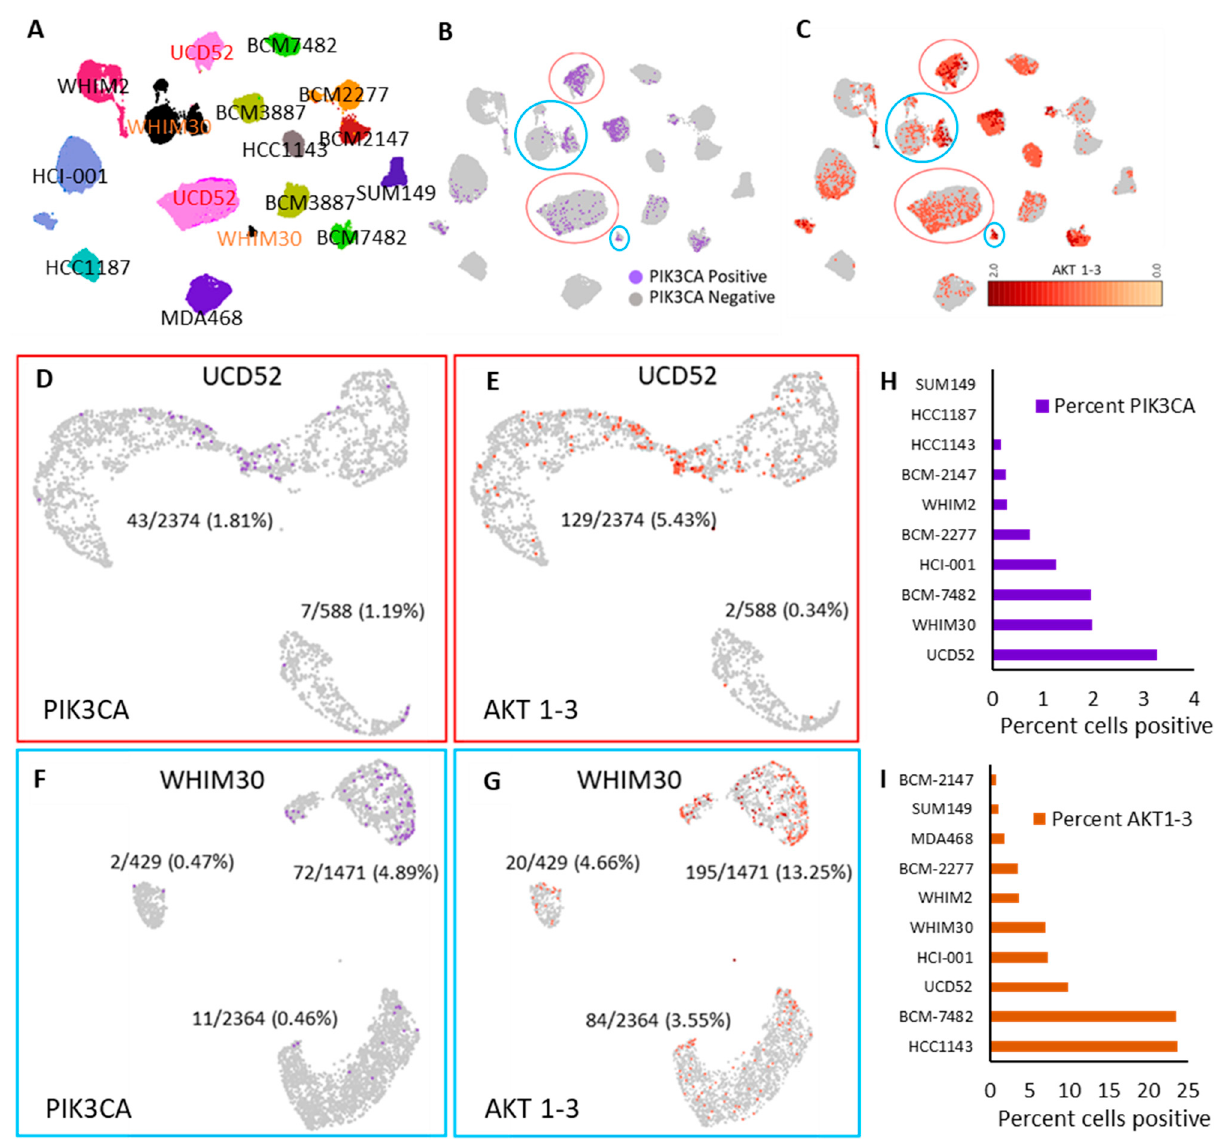
Figure 2. Subpopulations less reliant on the PIK3CA pathway were identified among 2 basal-like PDX models. ( A ) UMAP using the Gatza et al. The 2017 PIK3CA signature of scRNA sequencing data of basal-like models. Cells positive for ( B ) PIK3CA expression marked in purple and ( C ) by the level of AKT1-3 average expression. Unsupervised reclustering of ( D ) PIK3CA positive cells in UCD52 and ( E ) AKT 1-3 expression. Unsupervised reclustering ( F ) WHIM30 PIK3CA positive and ( G ) AKT1-3 expression. Percent positive (>0) ( H ) PIK3CA and ( I ) AKT1-3 cells per model.